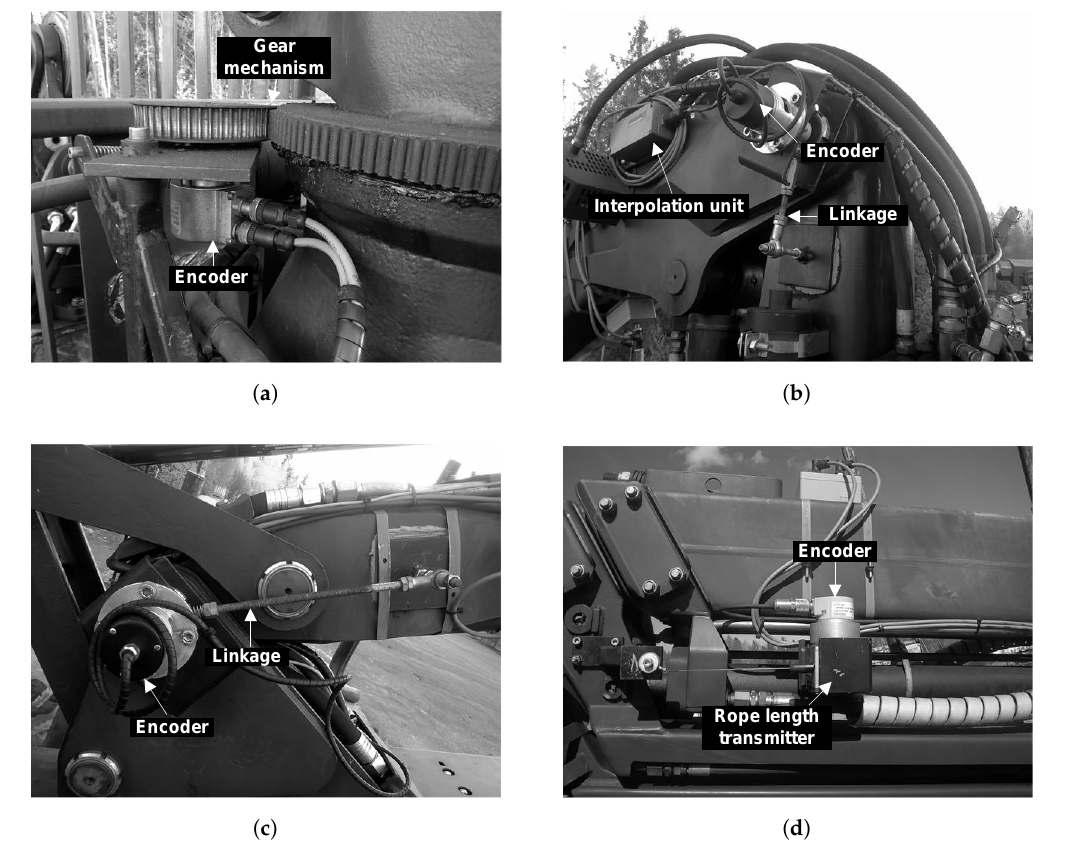
Figure 4. Joint encoders installed at the principal joints of the hydraulic manipulator: ( a ) Base angle ( q 1 ) encoder; ( b ) lift angle ( q 2 ) encoder; ( c ) tilt angle ( q 3 ) encoder; and ( d ) extension length ( q 4 )